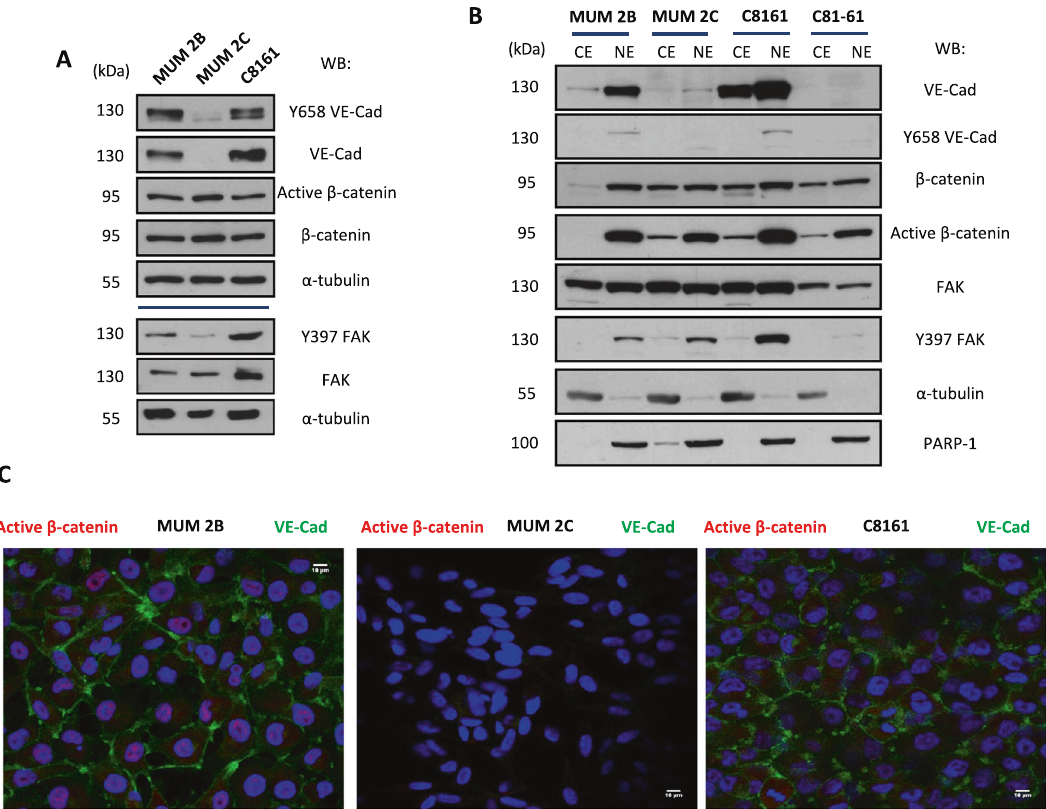
Fig. 2 Elevated expression of active β -catenin and Y397 phosphorylation of FAK in aggressive melanoma cells. A Total expression of VE- cadherin, Y658 VE-cadherin, of β -catenin or non-phospho β -catenin (active β -catenin), focal adhesion kinase (FAK) or the active form phospho FAK (Y397) were measured in aggressive melanoma cells (MUM 2B, C8161) and poorly melanoma cells (MUM 2C, C81-61), and B in a subfractionation experiment. C We con fi rm these results in an immuno fl uorescent experiment (active β -catenin: red, VE-cadherin: green and DAPI (nuclear stain, blue). Bars 15 μ m. D Immunochemistry analysis is performed to observe nuclear Y658 VE-Cadherin expression in melanoma in situ, metastasis patients. Consecutive sections are shown. Bars: 58 μ